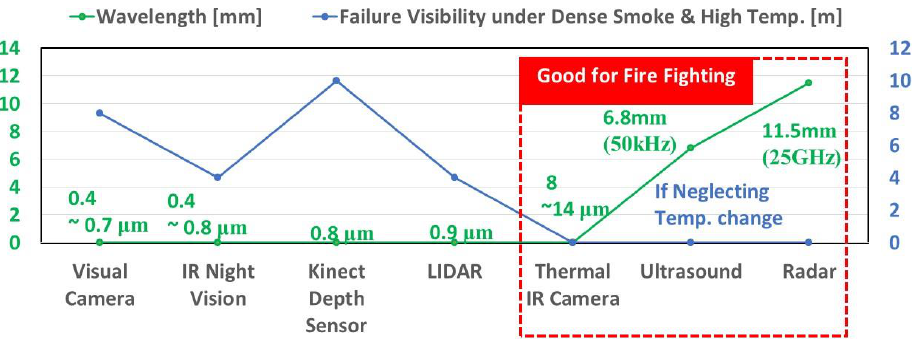
Figure 2. The relationship between visibility and wavelength of different perceptual sensors.